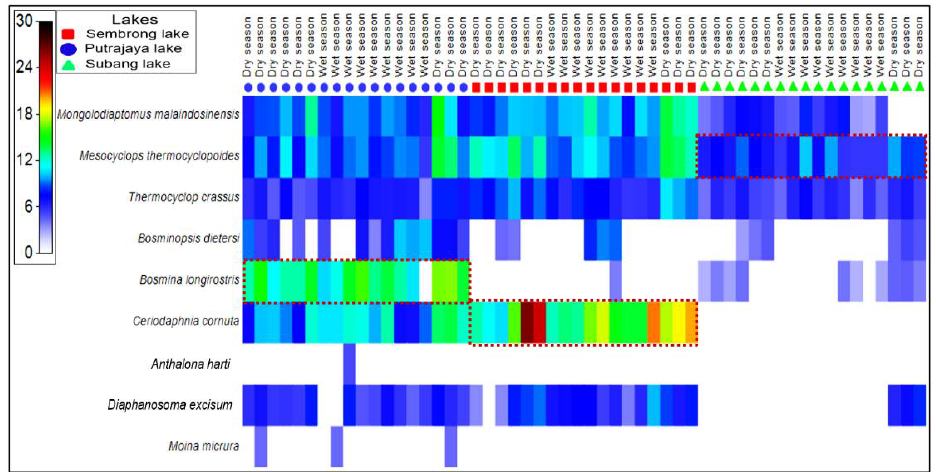
Table 5. Percentage contribution (%) of major microcrustacean species (>70%) for each lake based on similarity percentage (SIMPER) analysis. Av. Sim = average similarities, Contrib % = contribution percentages.